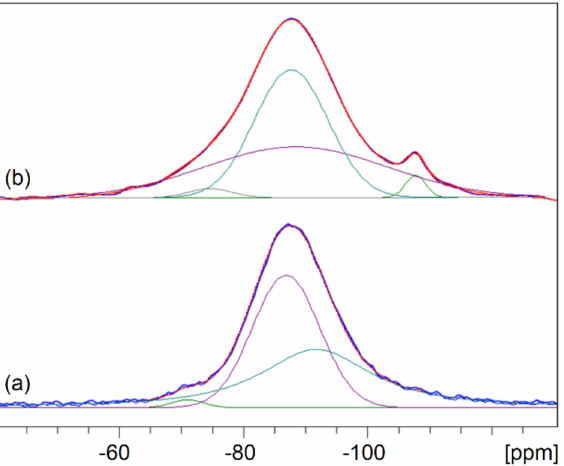
Figure 9. 29 Si MAS-NMR of G1 matrix ( a ), G2 matrix ( b ) with deconvolved